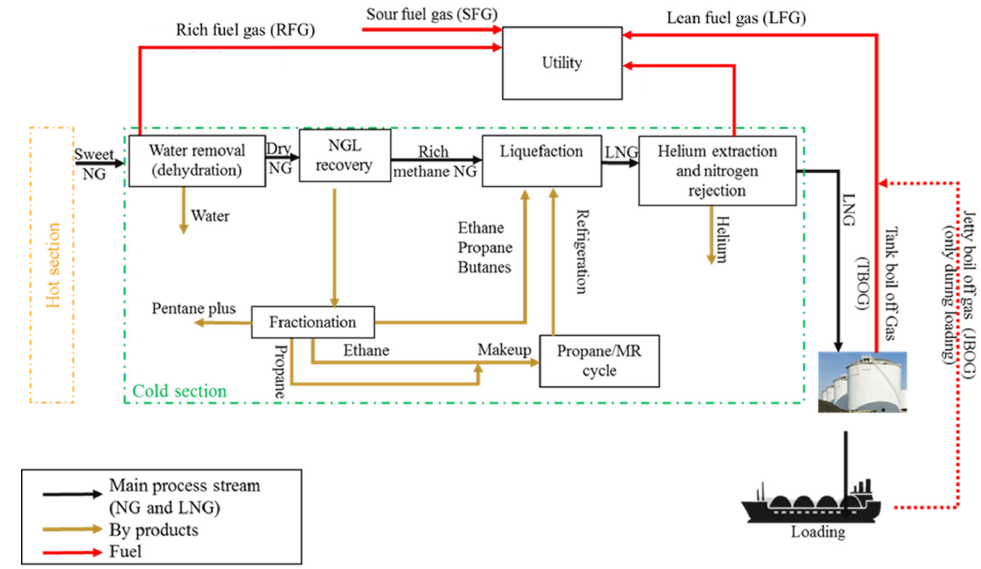
Figure 2. LNG plant flow block diagram.